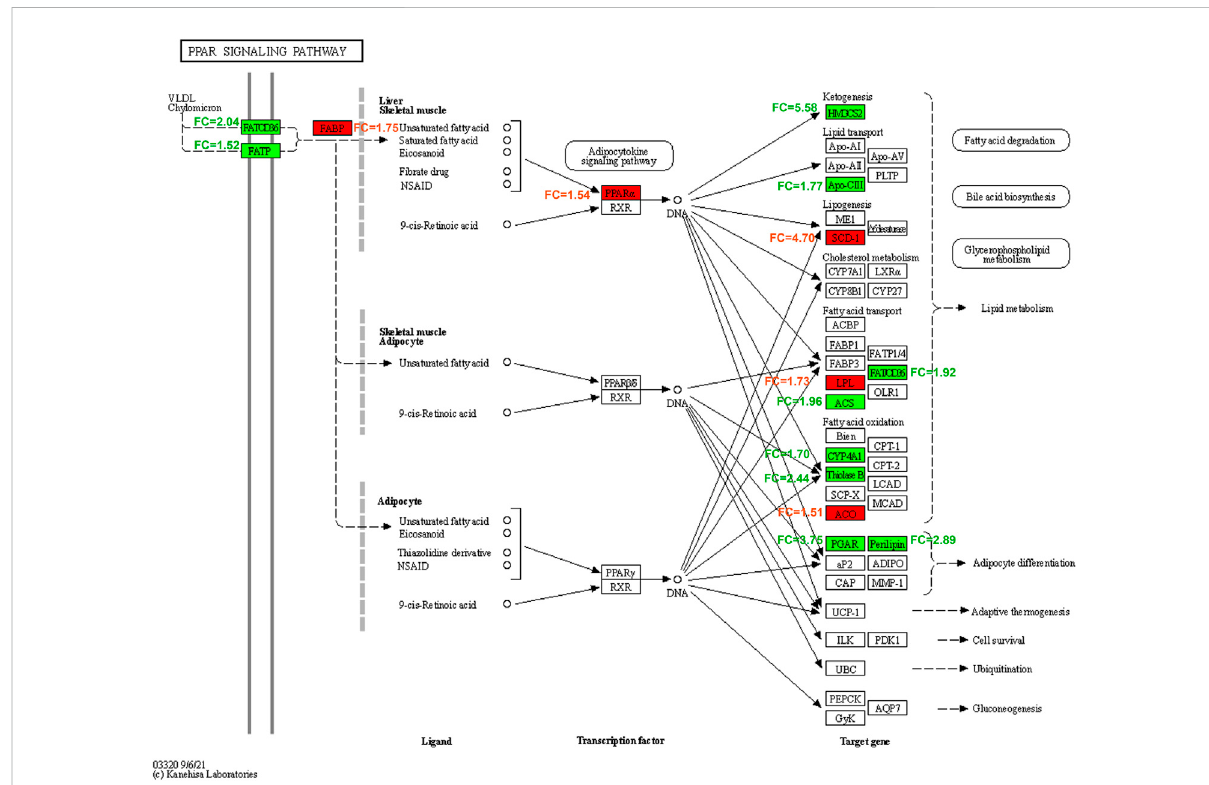
FIGURE 7 PPAR (peroxisome proliferator activated receptor) signaling pathway affected by Bailing Capsule in DN (diabetic nephropathy) rats. All the different expression genes of BC-H (high dosage of Bailing Capsule) group vs. DN group in PPAR pathway. Red represents up-regulated; green represents down-regulated, white represents no signi fi cant change. FC, fold change in BC-H vs. DN